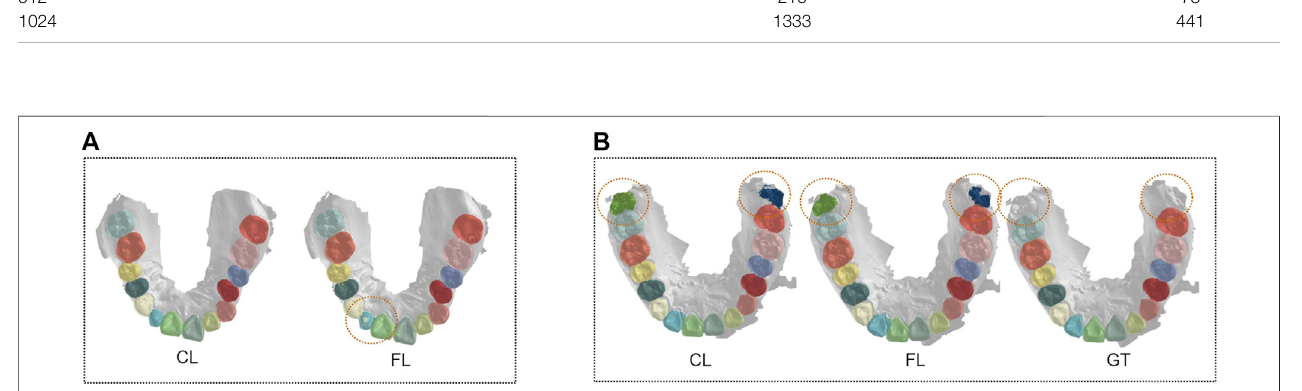
FIGURE 7 | Visualization of segmentation results under a centralized paradigm and federated learning framework. (A) Comparison between FL and CL. (B) Comparison between FL and GT.